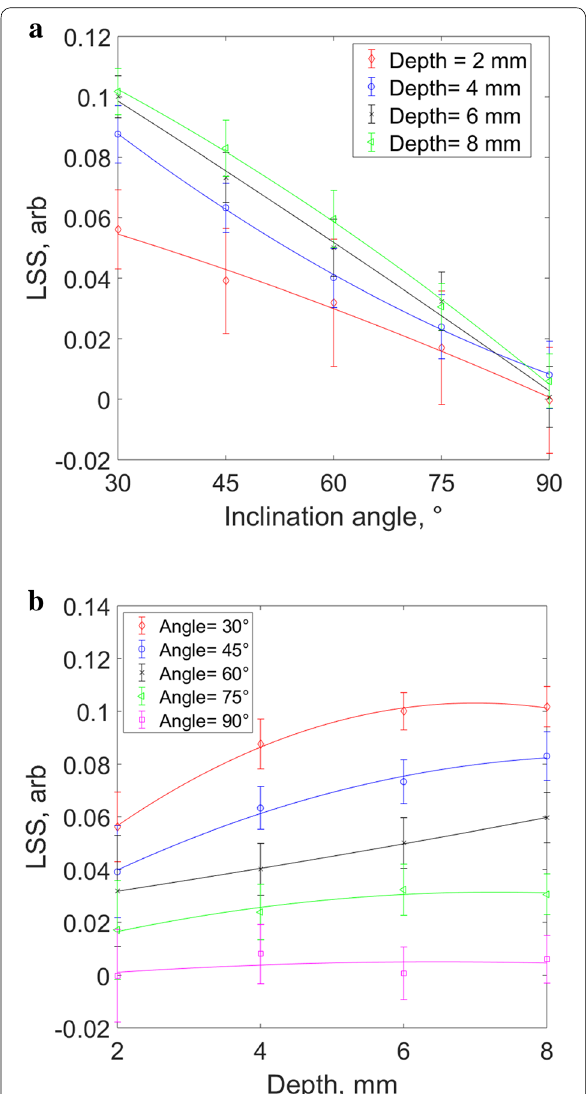
crack’s 2D scan images for automatic crack direction detection. Experimental measurements demonstrated a basis for developing an inverse model for defect quantification.